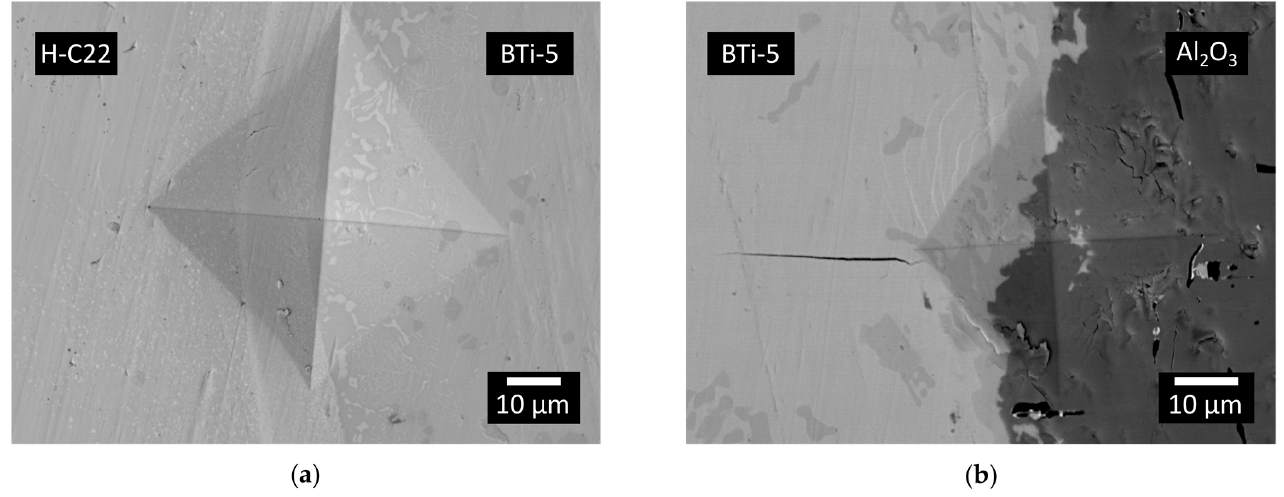
Figure 9. SEM-BED images representative of the Vickers indentation test performed at ( a ) H-C22/BTi-5 and ( b ) BTi-5/alumina interfaces.